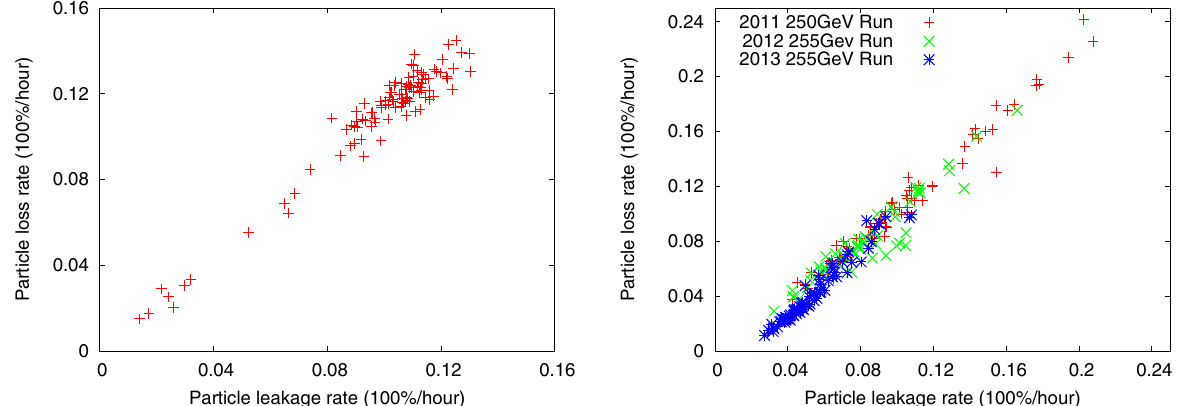
FIG. 9. Left: Correlation between the particle loss rate and the particle leakage rate during the first hour of store for all the bunches of Fill 16697. Right: Correlation between the particle loss rate and the particle leakage rate during the first hour of store for the beam in the Blue ring for all the physics stores in the past 250 = 255 GeV proton runs.